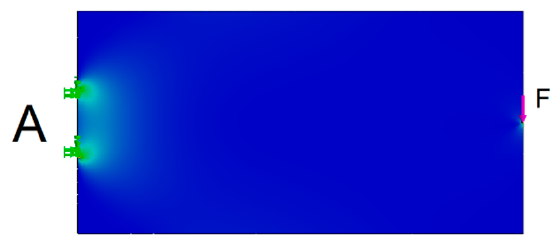
Figure 8. Load and joint of the base beam A (stress diagram).